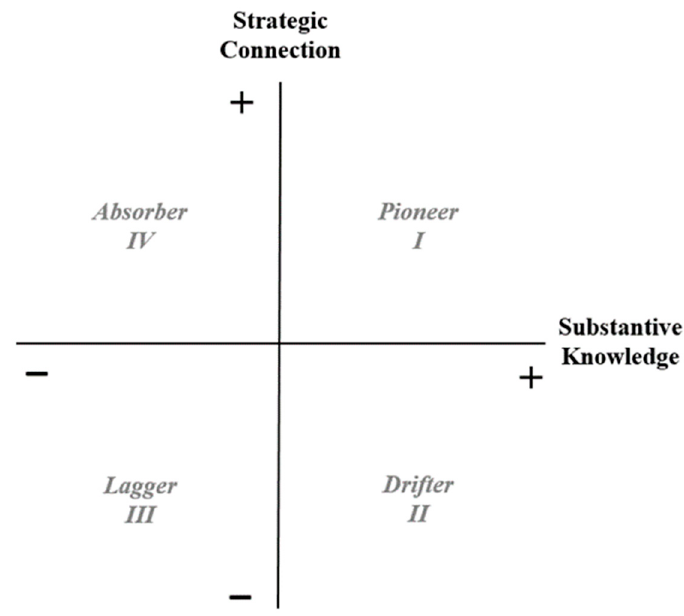
Figure 3. Strategic competence of territorial units.